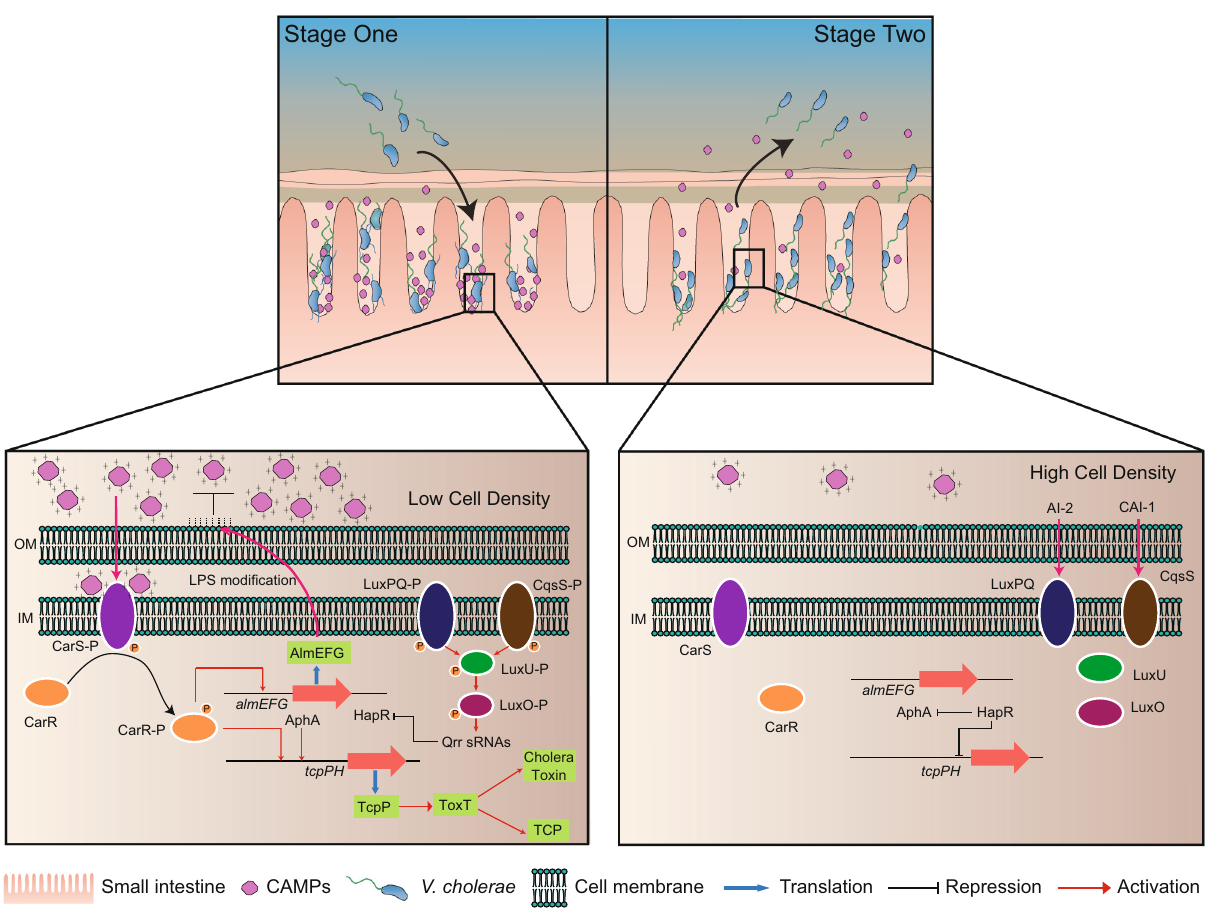
Fig. 7 Graphic model of CarSR-mediated HD-5 signaling pathway in V. cholerae . At initial stage (Stage One) of colonization, CarSR is activated by sensing HD-5 to promote the expression of tcpP and almE . At late stage (Stage Two) of infection, CarSR is inactivated due to the decreased HD-5 concentration, which lead to the repression of virulence genes